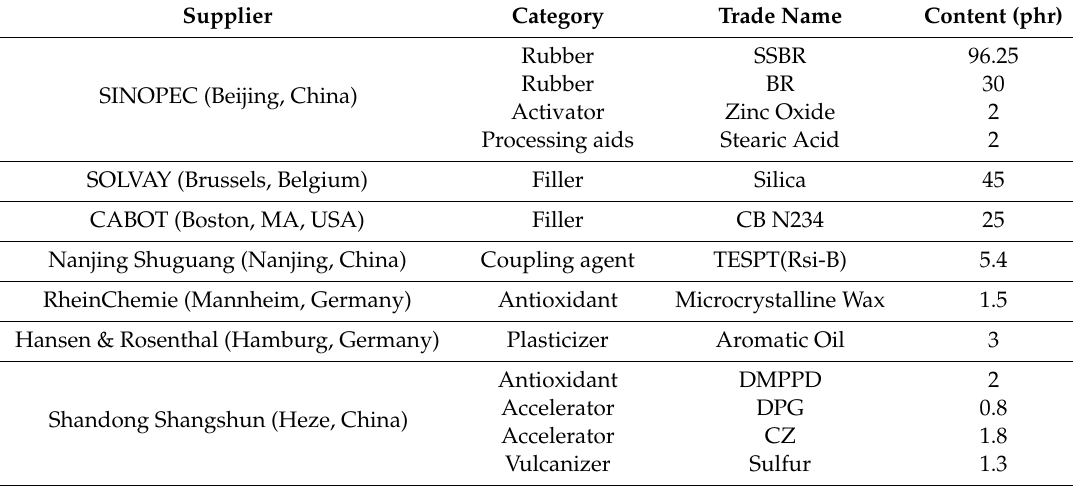
Table 1. Semi-steel tread